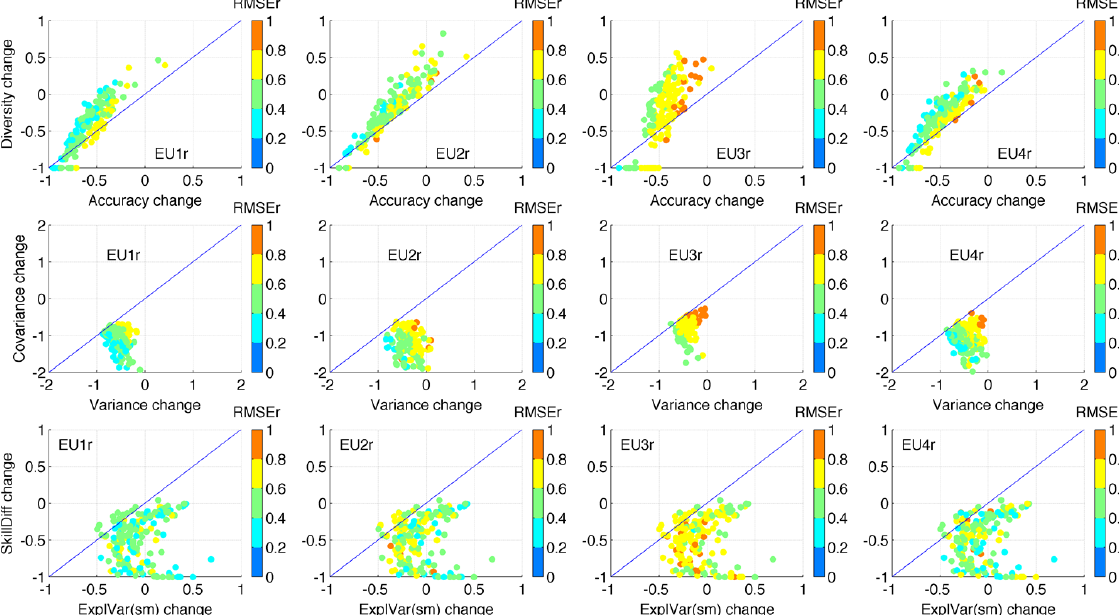
Figure 6. Comparison between mmeS and mme with respect to the error decomposition. Each of the 92 dots corresponds to an individual 1- day simulation. The colour scale represents the RMSE ratio calculated as property(mmeS)/property(mme). Top: fractional change in accuracy versus fractional change in diversity. Middle: fractional change of variance versus fractional change of covariance. Bottom: fractional change in skill difference versus fractional change in error correlation. Please note the different range of the y -axis between the different panels.